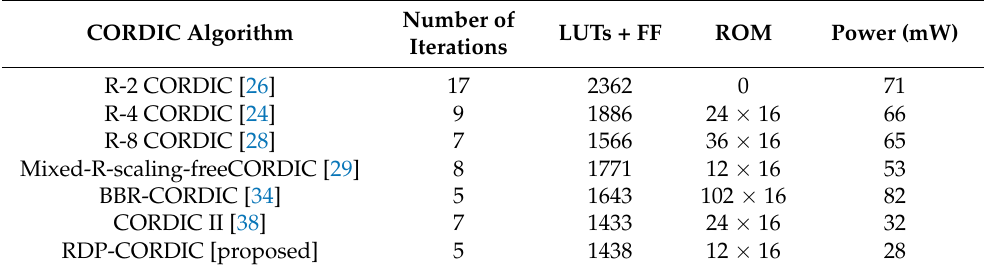
Table 6. Performance comparison results of different CORDIC